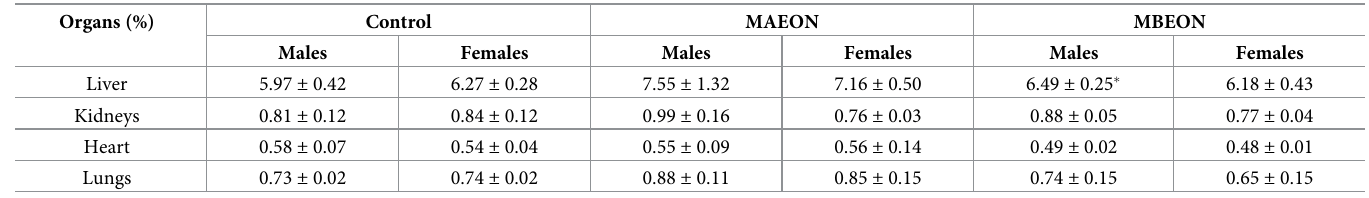
Values are expressed as mean ± standard deviation (n = 3). Statistical significance was calculated using One-way Anova followed by Bonferroni’s multiple comparison test (p <